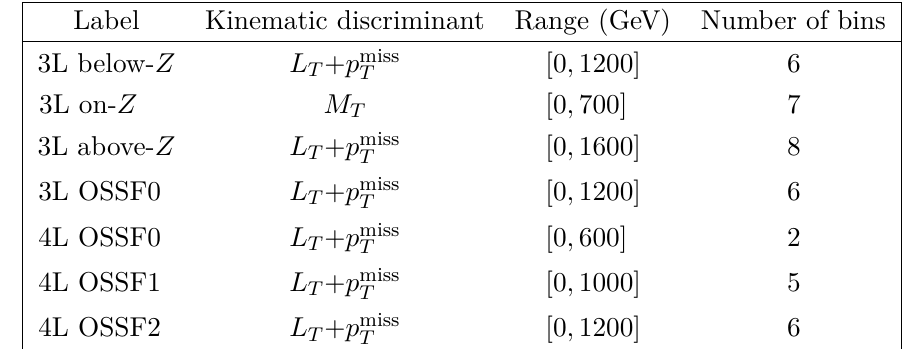
Table 6 . Multilepton signal regions. See text for